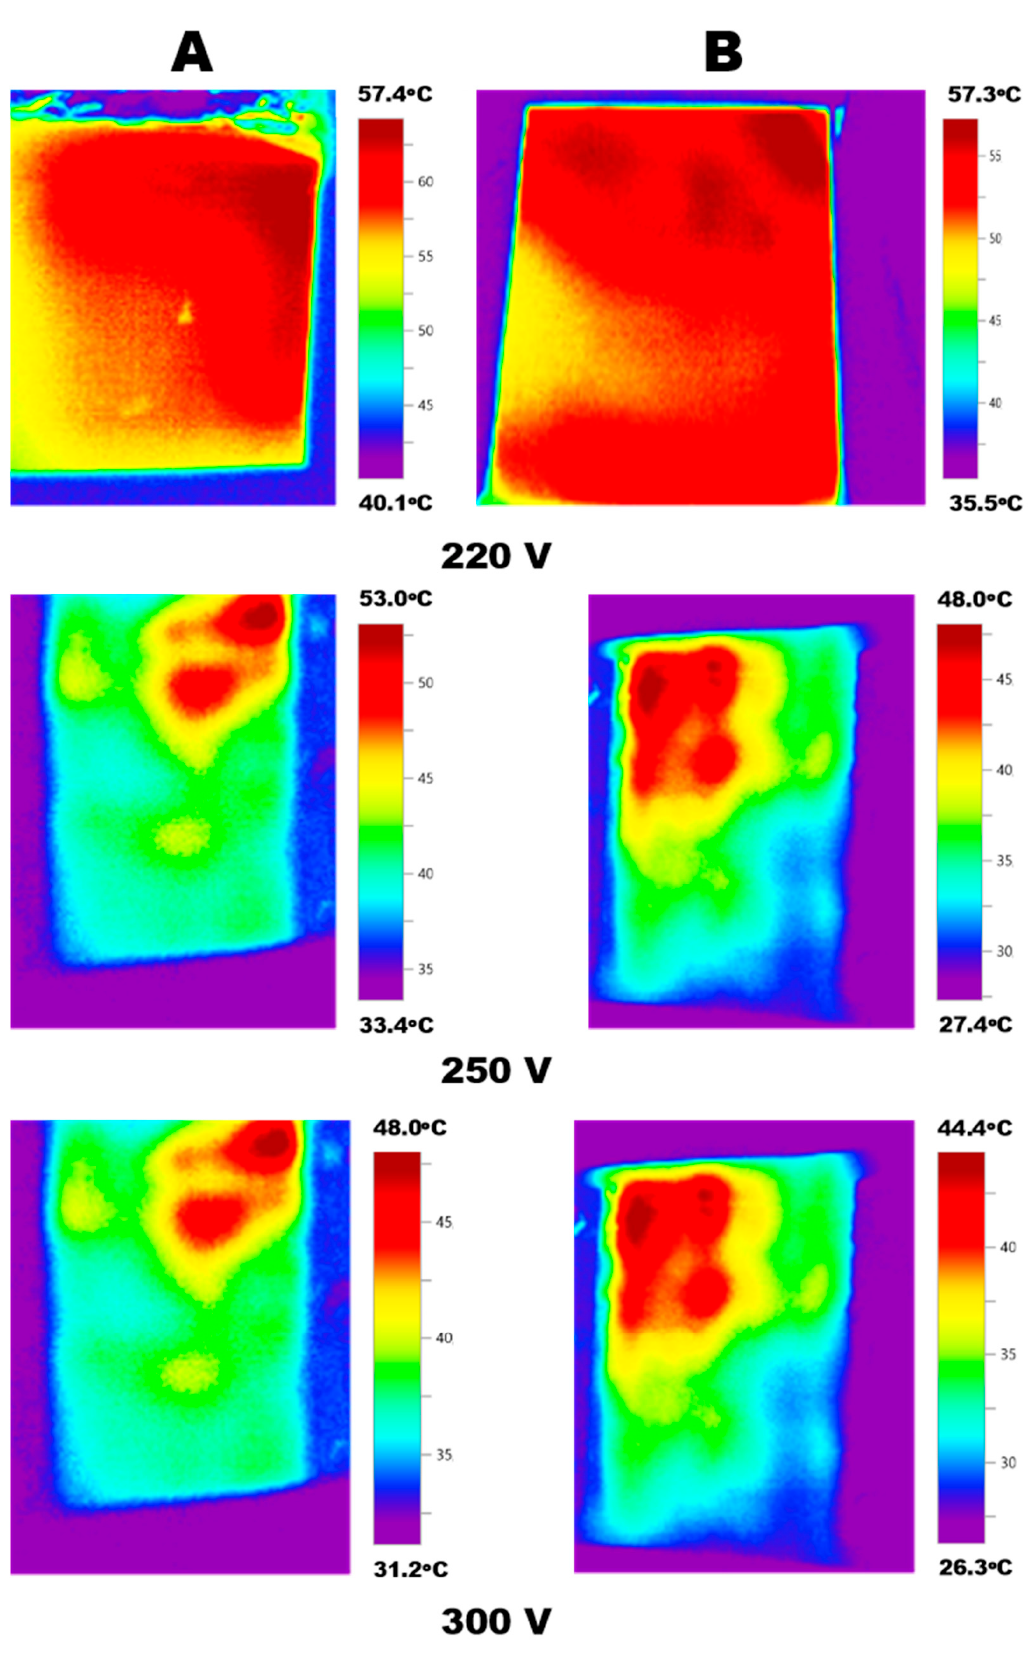
Figure 5. The comparison of the temperature fields for ( A ) NCO 1 and ( B ) NCO 2 at different voltages.